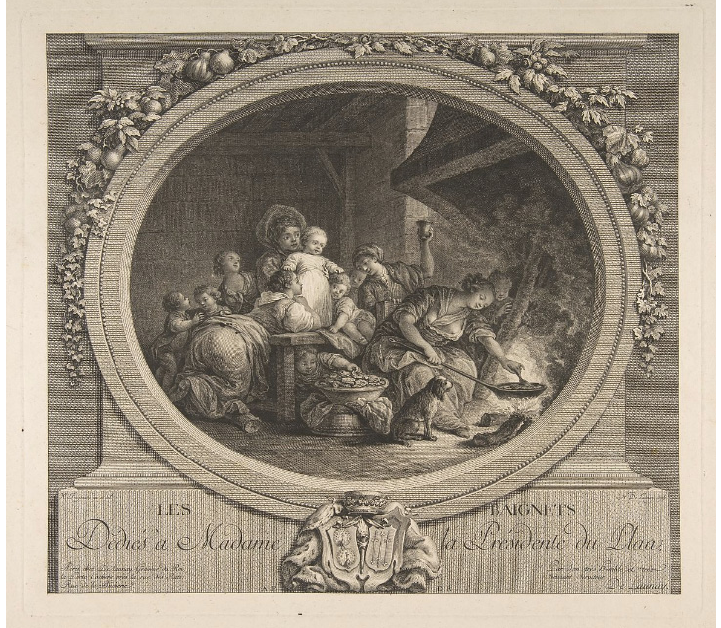
Figure 1. Nicolas de Launay (France, 1739–1792) After Jean Honoré Fragonard, Les Baignets , 1783, Etching and engraving, 26.7 cm × 30.1 cm, Metropolitan Museum of Art, New-York, Purchase, Roland L. Redmond Gift, Louis V. Bell and Rogers Funds 1972 (1972.539.13).